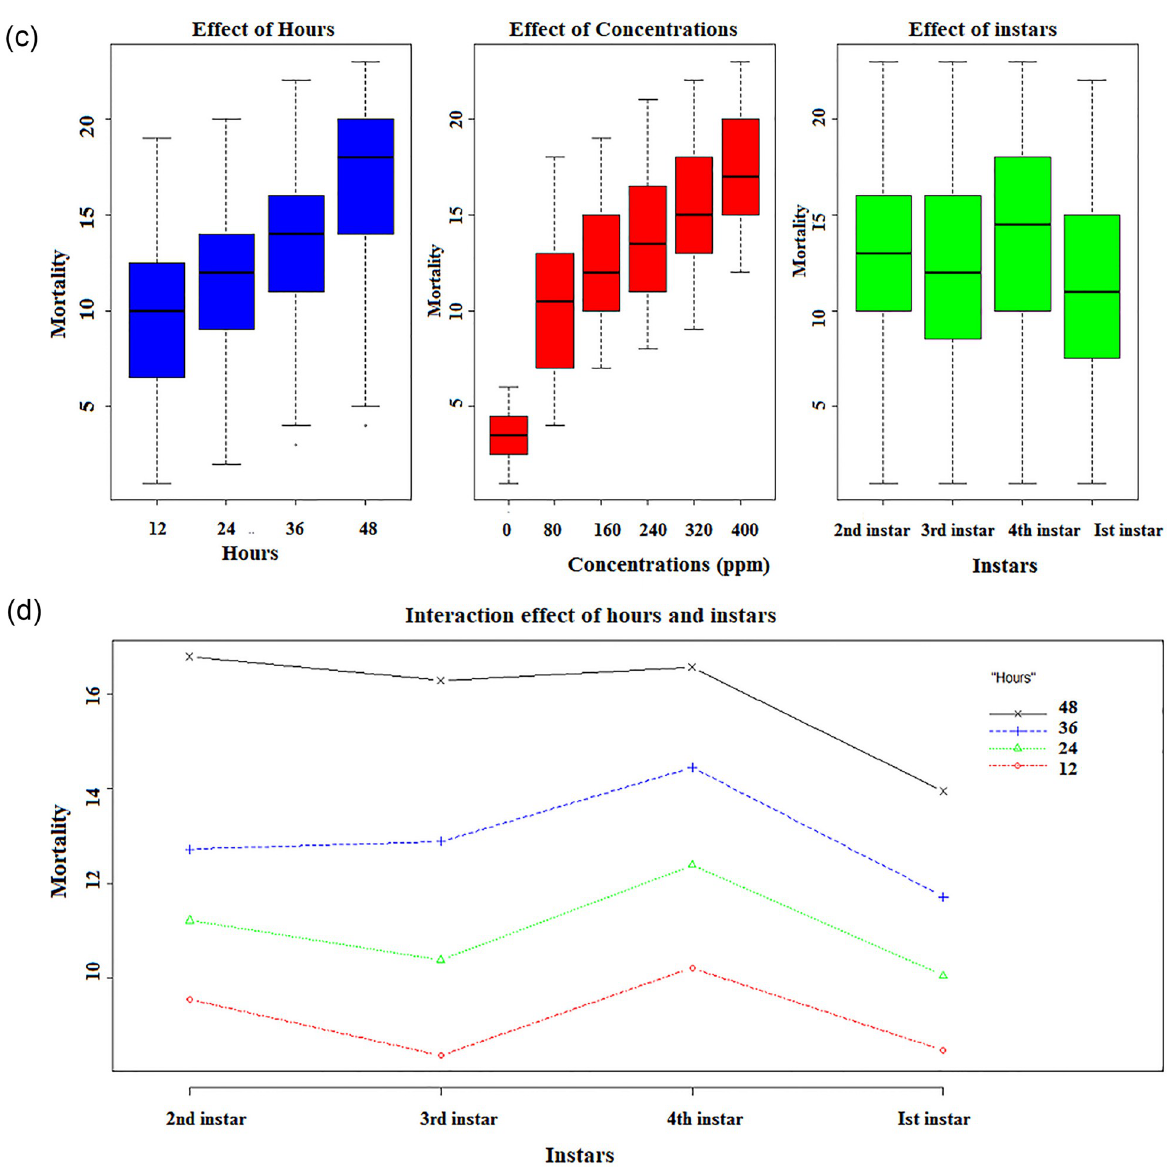
Fig 2. (c) Box plot representing the effect of hours, concentrations, and plant on the mean mortality of I st , 2 nd , 3 rd , and 4 th instars larvae in a water solvent. (d) Interaction plot representing the interacting effect of hours with instars on the mean mortality of I st , 2 nd , 3 rd , and 4 th instars larvae in a water